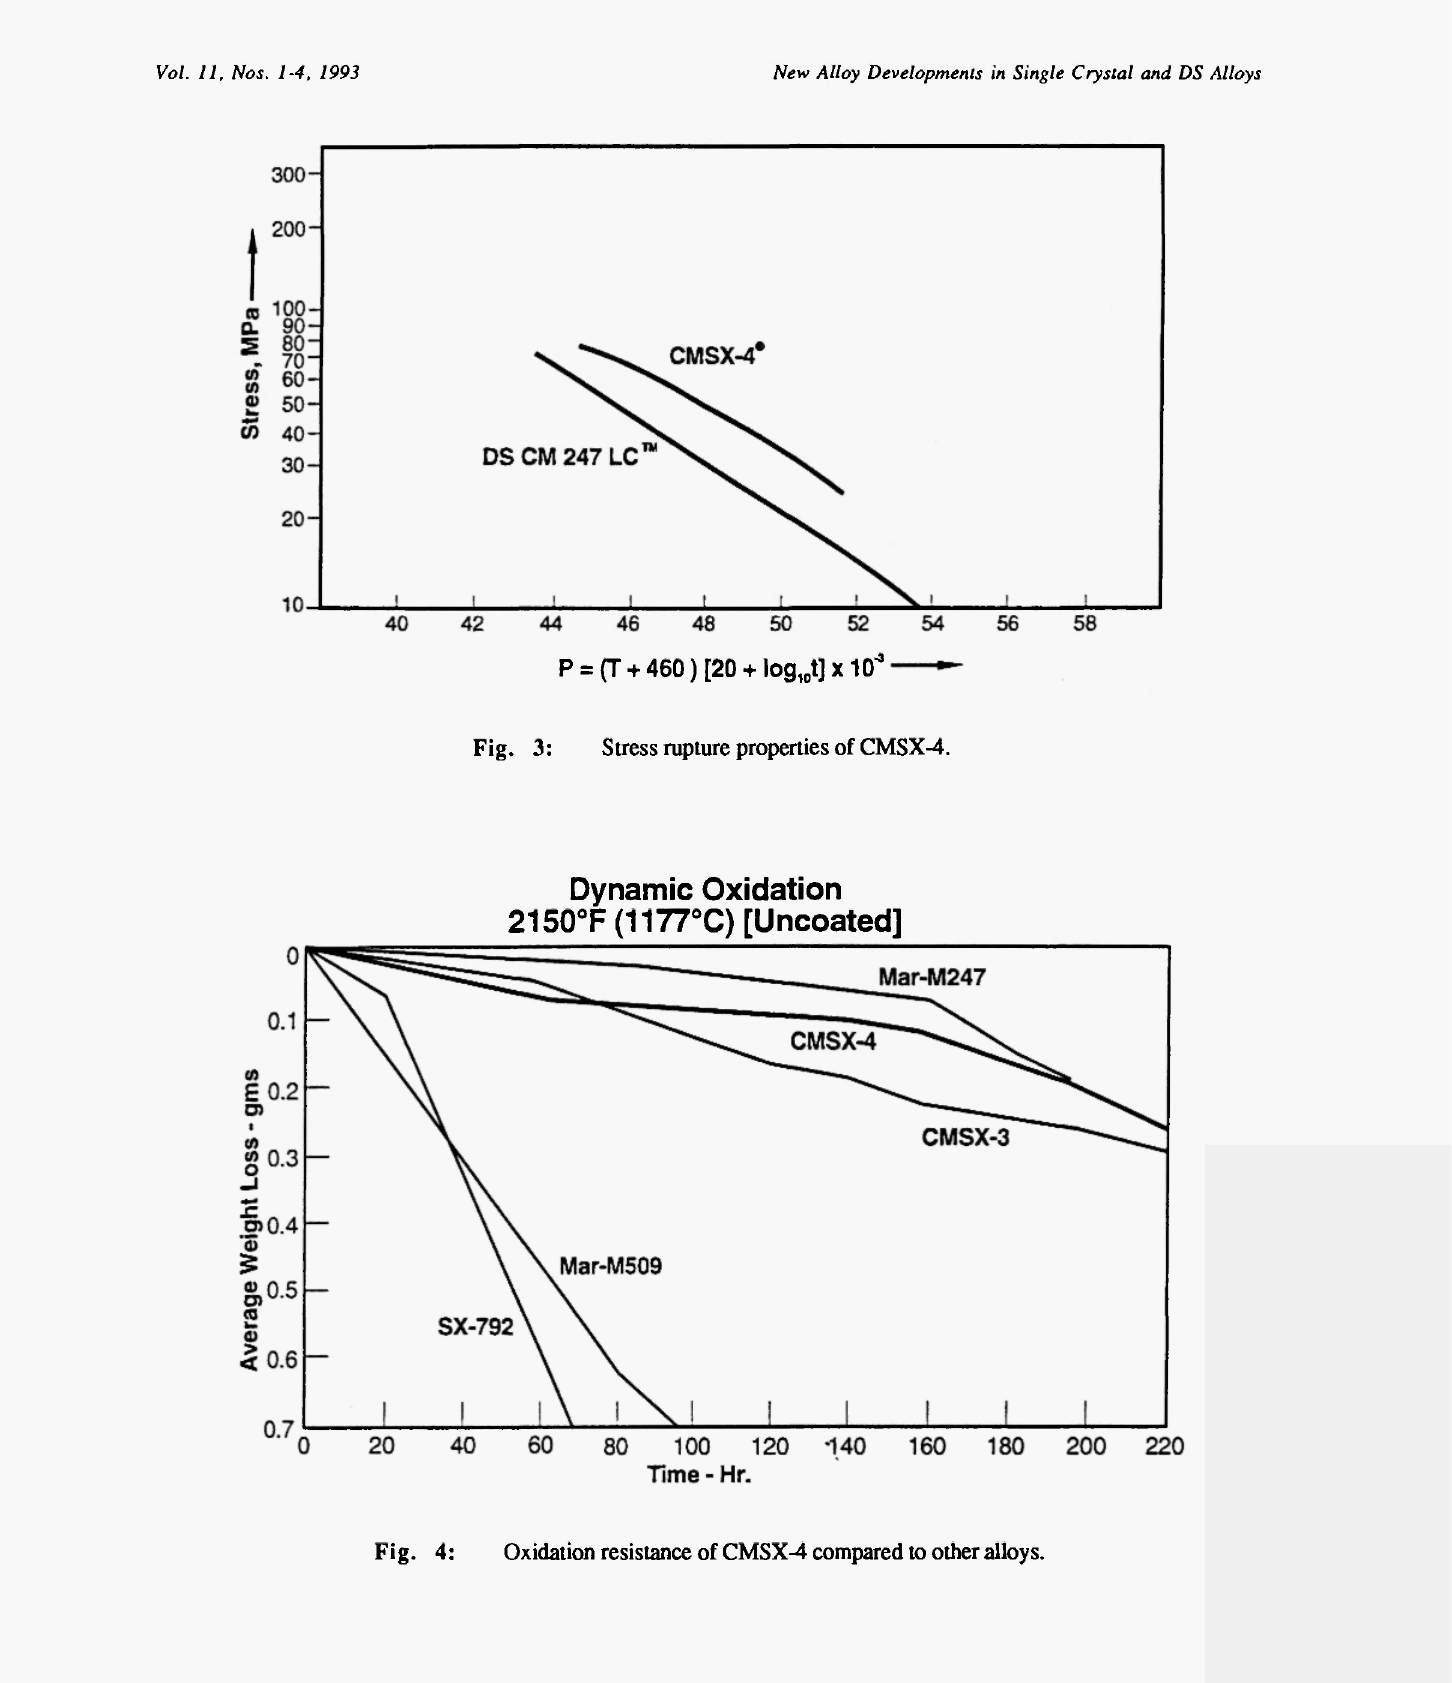
Fig. 4: Oxidation resistance of CMSX-4 compared to other